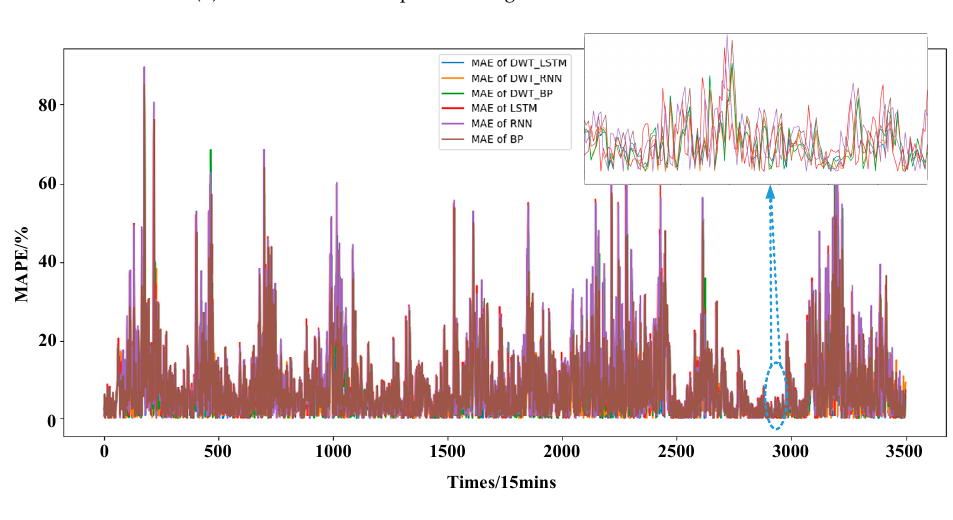
(b) MAPE of three-step forecasting based on six methods for farm 2.